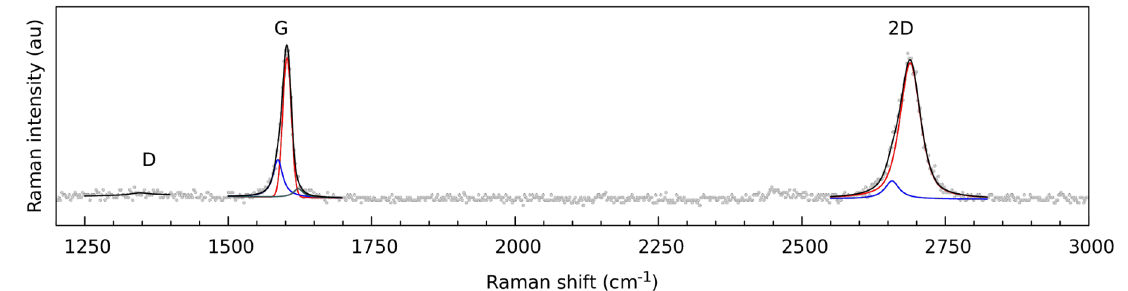
Figure 2. Typical Raman spectrum of graphene, which is transferred using NC. The experimental data are marked by gray dots and fits of the individual bands are shown in red for the G 1 and 2D 1 components, blue for the G 2 and 2D 2 components and grey for the D’ component, respectively. The resulting curve (sum of the individual components) is represented by a solid black line.